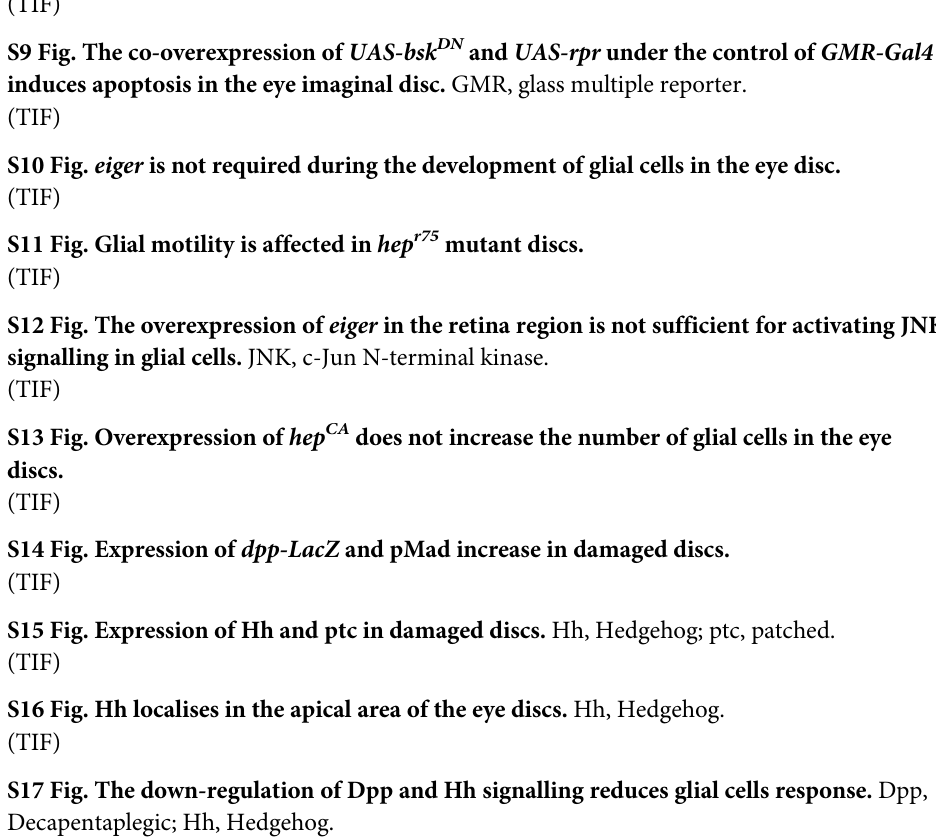
S7 Fig. JNK signalling is activated in response to damage. JNK, c-Jun N-terminal kinase. (TIF) S8 Fig. puc reporter. puc , puckered . S9 Fig. The co-overexpression of UAS-bsk DN and UAS-rpr under the control of GMR-Gal4 induces apoptosis in the eye imaginal disc. GMR, glass multiple reporter. (TIF) S10 Fig. eiger is not required during the development of glial cells in the eye disc. (TIF) S11 Fig. Glial motility is affected in hep r75 mutant discs. (TIF) S12 Fig. The overexpression of eiger in the retina region is not sufficient for activating JNK signalling in glial cells. JNK, c-Jun N-terminal kinase. S13 Fig. Overexpression of hep CA does not increase the number of glial cells in the eye discs. S14 Fig. Expression of dpp-LacZ and pMad increase in damaged discs. (TIF) S15 Fig. Expression of Hh and ptc in damaged discs. Hh, Hedgehog; ptc, patched. (TIF) S16 Fig. Hh localises in the apical area of the eye discs. Hh, Hedgehog. (TIF) S17 Fig. The down-regulation of Dpp and Hh signalling reduces glial cells response. Dpp, Decapentaplegic; Hh, Hedgehog. S18 Fig. The overexpression of dpp and hh induces over migration and proliferation of glial cells. Dpp, Decapentaplegic; Hh, Hedgehog. S19 Fig. Ptc is expressed at high levels in discs overexpressing ihog . ptc, patched. (TIF) S20 Fig. Overexpression of dpp in the retina region induces activation of JNK signalling in glial cells. Dpp, Decapentaplegic; JNK, c-Jun N-terminal kinase. S21 Fig. The down-regulation of JNK signalling does not impair the ability of glial cells to engulf cellular debris. JNK, c-Jun N-terminal kinase. S22 Fig. JNK signalling is mediating the glial response triggers after cell death induction in the leg discs. JNK, c-Jun N-terminal